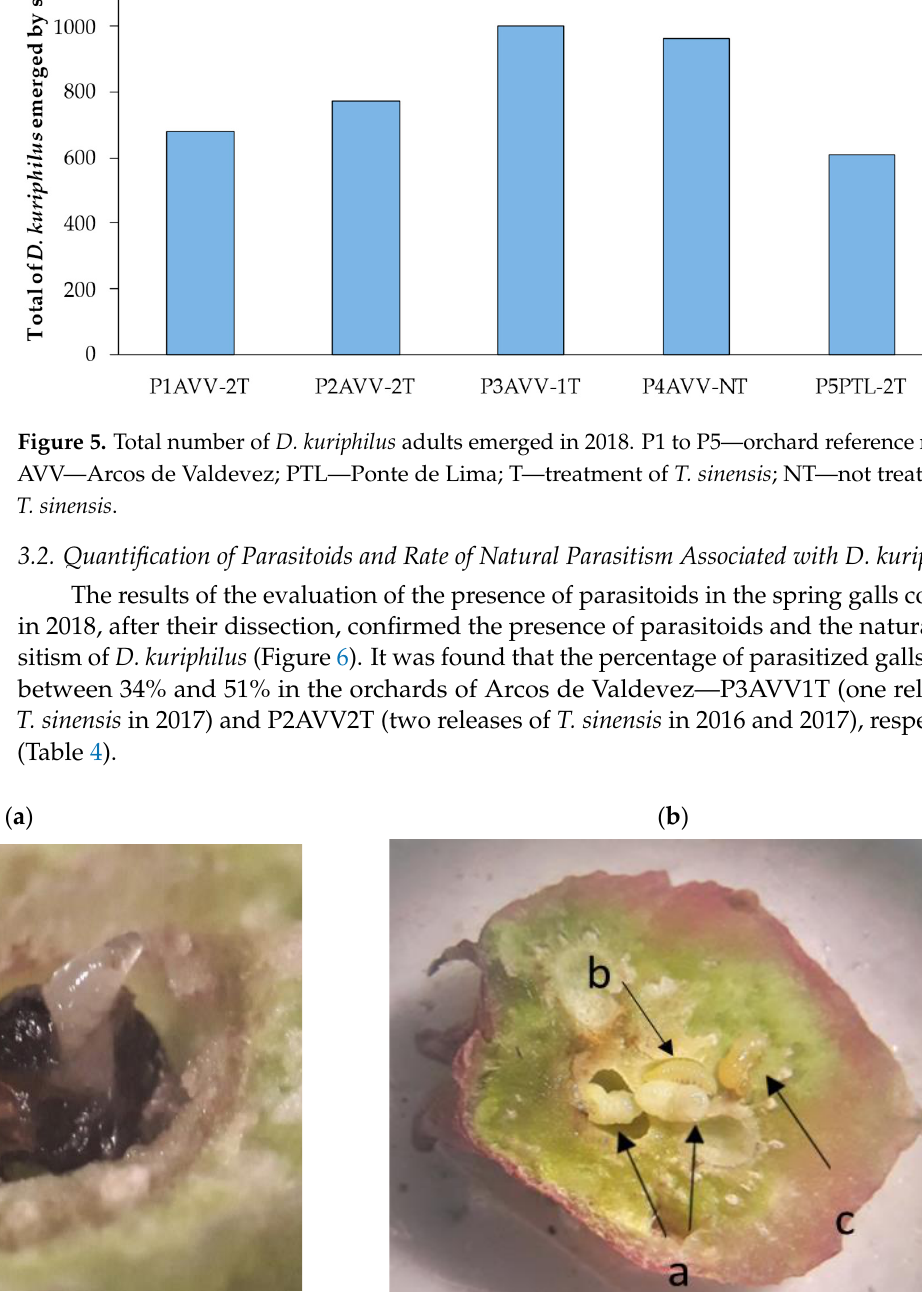
Figure 4. Weekly evolution of D. kuriphilus emergence in five chestnut orchards in Minho (P1–P5) located in Arcos de Valdevez (AVV) and Ponte de Lima (PTL), with one (1T), two (2T) or no treatment (NT) of T. sinensis in 2018.